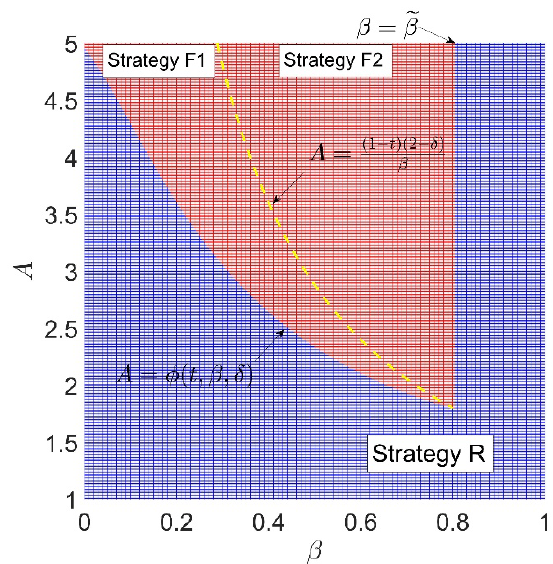
Figure 2. The decision region of technology licensing strategy.